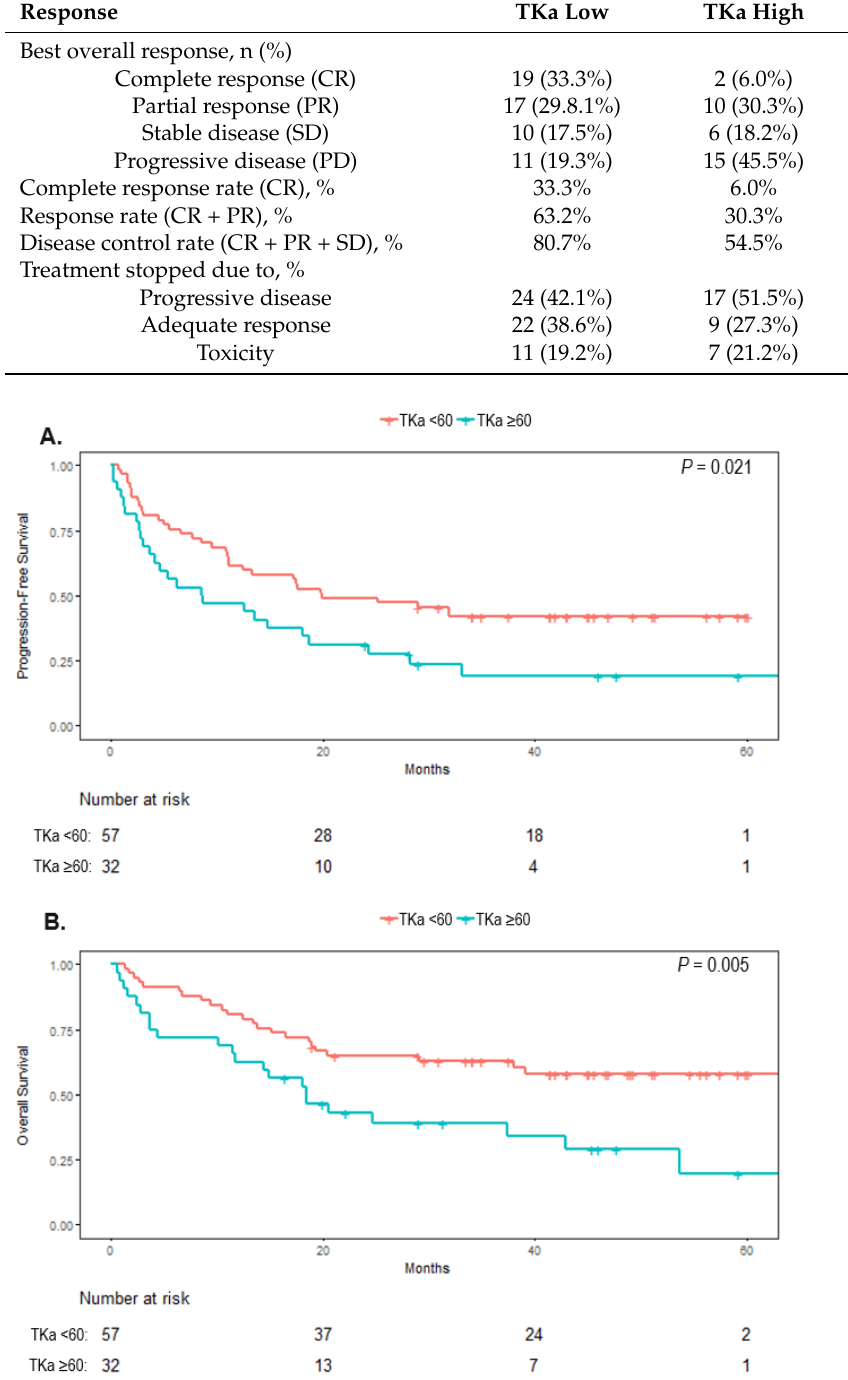
Figure 2. Kaplan–Meier curves for survival in melanoma patients with high (>60 Du/L) or low thymidine kinase 1 activity (TKa) in plasma before starting a treatment with immune checkpoint inhibitors. ( A ). The median progression-free survival was, in patients with low TKa, 19.9 months (95% CI, 11.0 to not reached) and in patients with high TKa, 12.6 months (95% CI, 3.6 to 28.3) ( p = 0.021). ( B ). The median overall survival was not reached in patients with low TKa (>60 months, 95% CI, 38.0 to not reached), and in the patients with high TKa it was 18.5 ( p = 0.005).